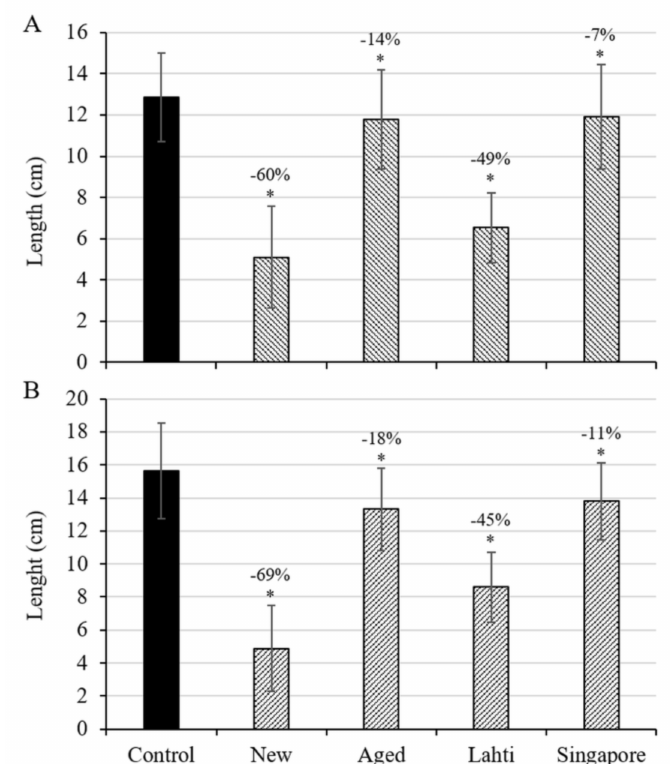
Figure 1. Average root ( A ) and shoot length ( B ) of T. aestivum seedlings exposed to ≤ 4 mm microplas- tic derived from treated bottle caps (new, artificial aged, caps collected in Lahti and Singapore) in the soil after seven days of exposure compared to controls without microplastic in soil. Data represent mean length ± standard deviation and significance compared to the control is represented by an asterisk (*) where p < 0.05 ( n = 400).